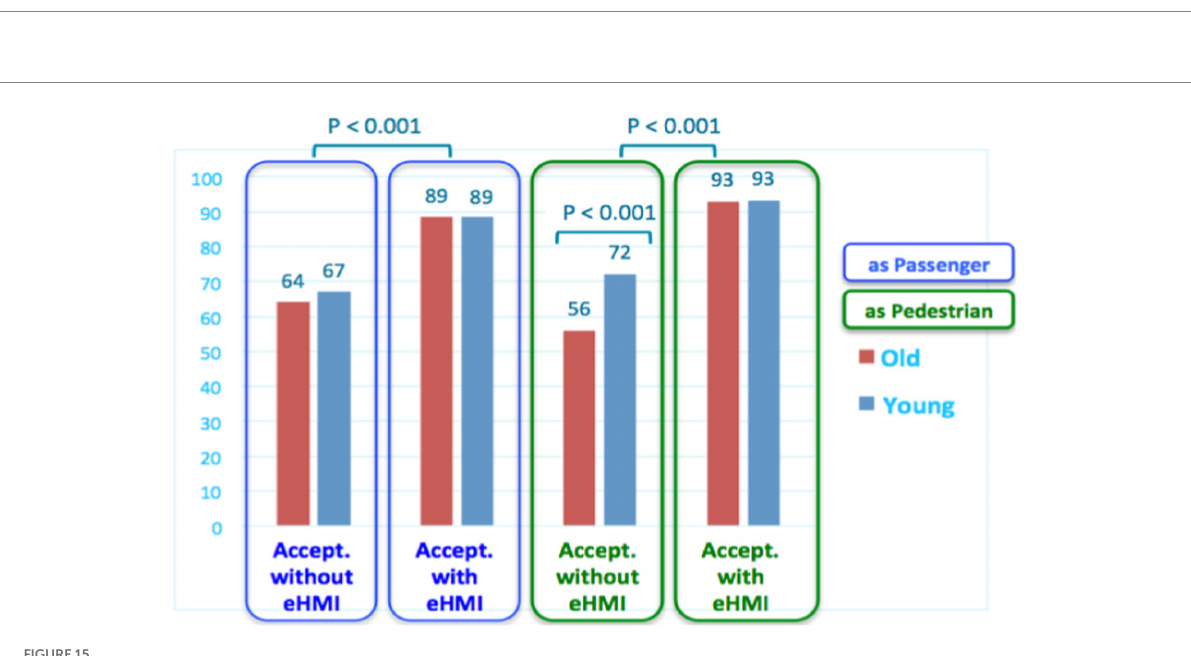
FIGURE 14 Safety assessment of AV (with eHMI) behavior to yield, as a pedestrian.